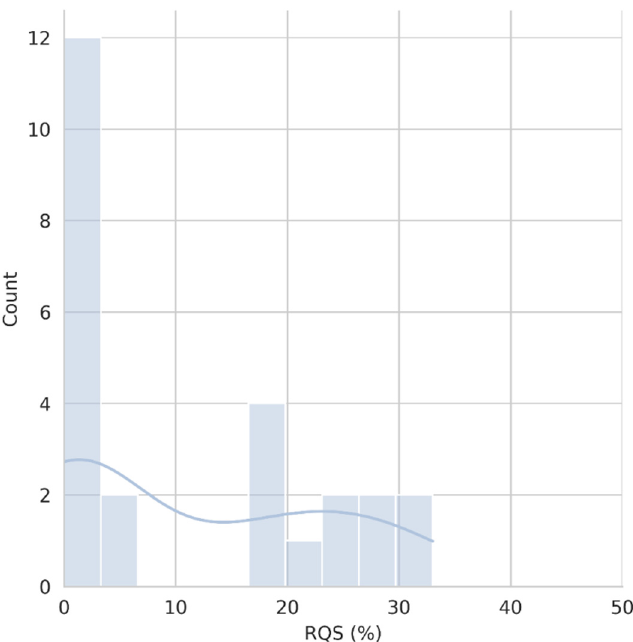
Figure 3. Distribution of RQS percentage score of the papers included in our review. This is presented both as a histogram (bars) and its corresponding density function (line).